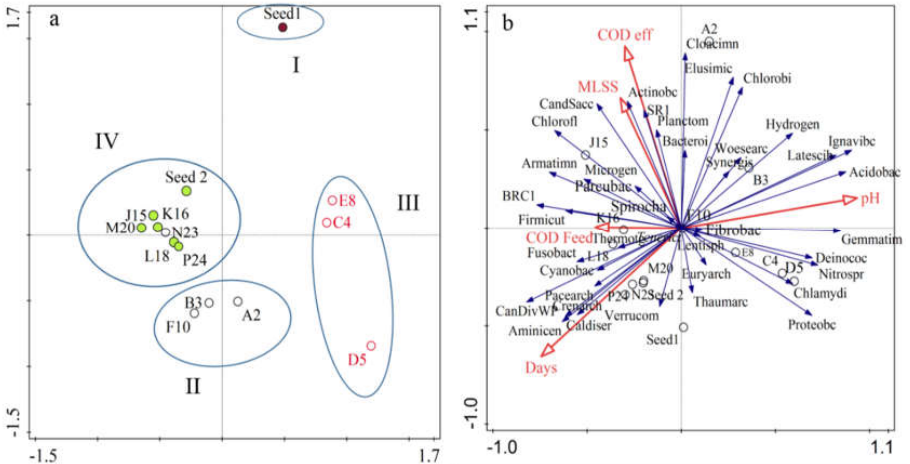
Figure 4. Principal component analysis (PCA) of microbial community at phylum level for samples ( a ); and Redundancy analysis (RDA) of microbial community and environmental factors ( b ).